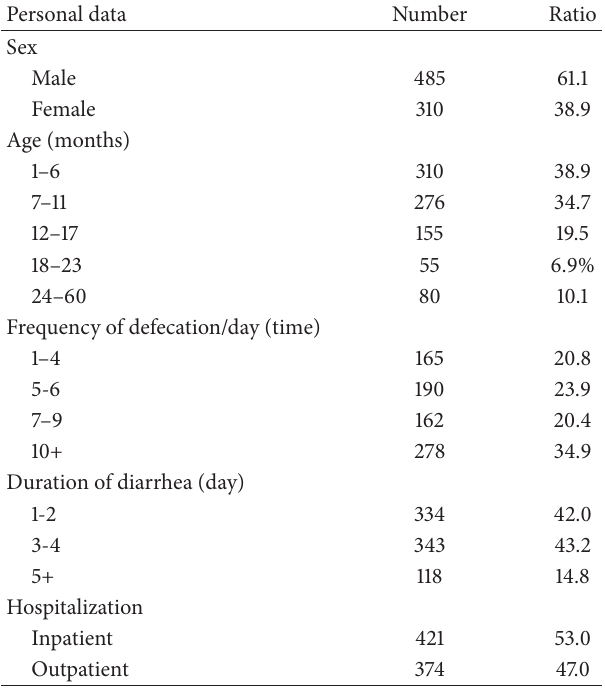
Table 1: General characteristics of patients (𝑛 = 795) .